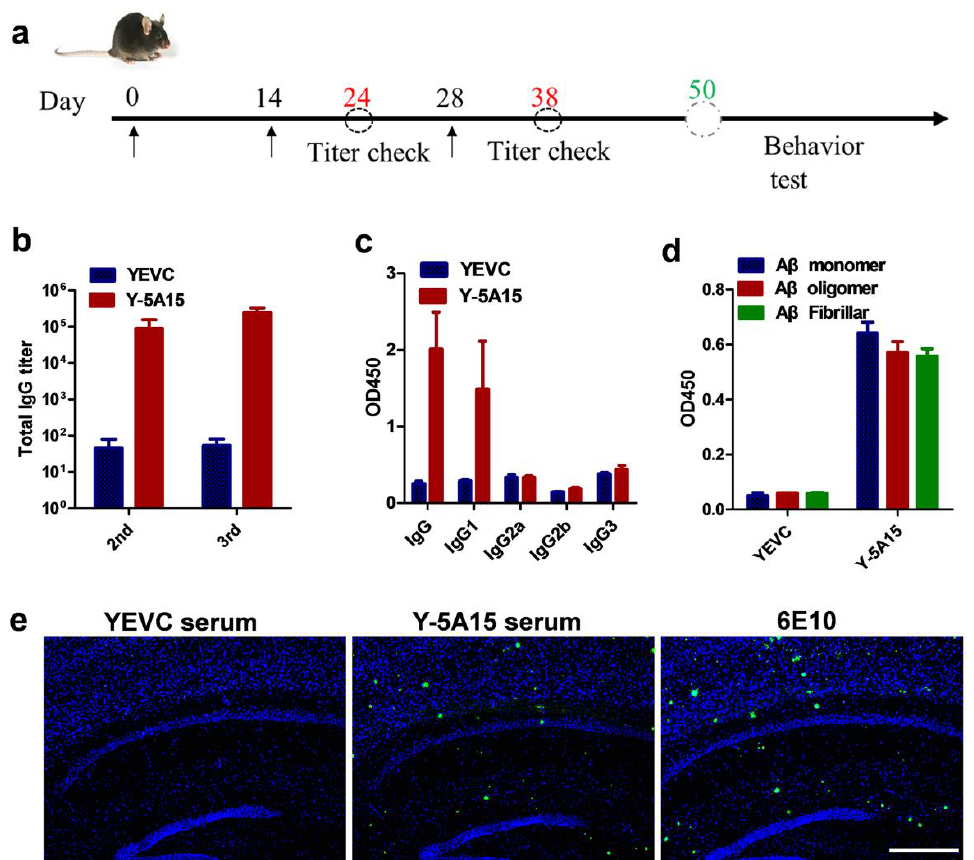
Figure 2. The anti- Aβ response of plasma antibody induced by Y-5A15 vaccine. ( a ) Schematic diagram of vaccine immunization for APP/PS1 mice ( n = 6). ( b ) Aβ 42 antibody levels induced by Y-5A15 vaccine. ( c ) The subtypes of vaccine- induced antibodies against Aβ 42 . ( d ) The binding of antibodies induced by Y- 5A15 vaccine to different Aβ isoforms was detected by ELISA. ( e ) Mice AD brain sections were stained using serum from Y-5A15-vaccinated APP/PS1 mice. Brain tissue was detected via IHC using serum from YEVC (1:200)- or Y-5A15 (1:200)- treated mice. Scale bar is 500 μm.